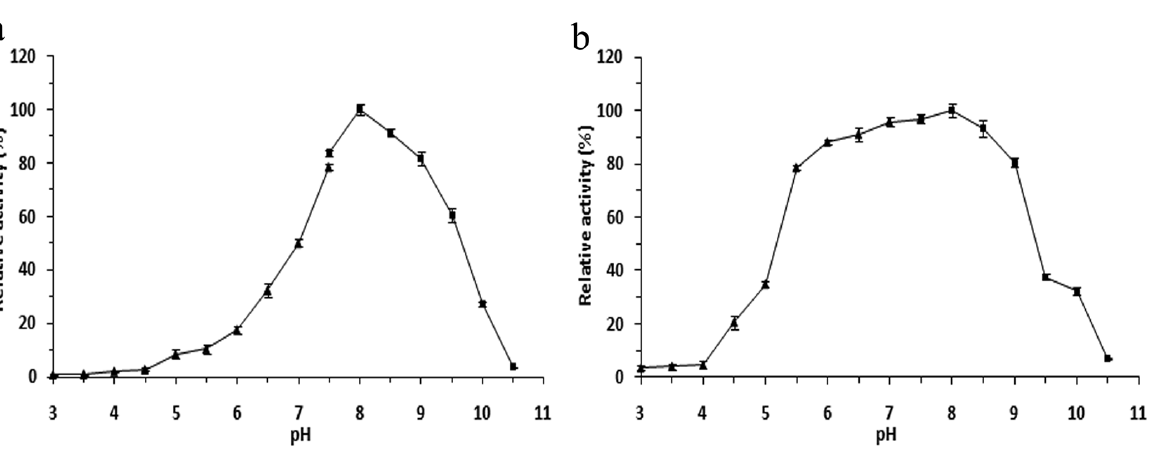
Figure 4. Effect of pH on activity and stability of r-LipA. ( a ) Effect of pH on r-LipA activity. The reaction was carried out at 30 °C in buffers with pH ranging from 3.0 to 10.5; ( b ) pH stability of r-LipA. The residual activity of r-LipA was determined at 30 °C after 8 h pre-incubation at 4 °C in buffers ranging from pH 3.0 to 10.5. The following buffers were used: McIlvaine buffer (pH 3.0–7.5, filled triangle); 50 mM Tris-HCl buffer (pH 7.5–10.5, filled square). All measurements were carried out in